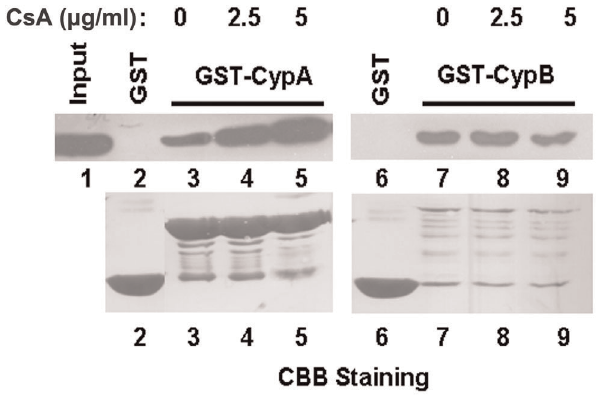
PR8 were subcloned into the plasmid pCMV-Tag2, respectively.